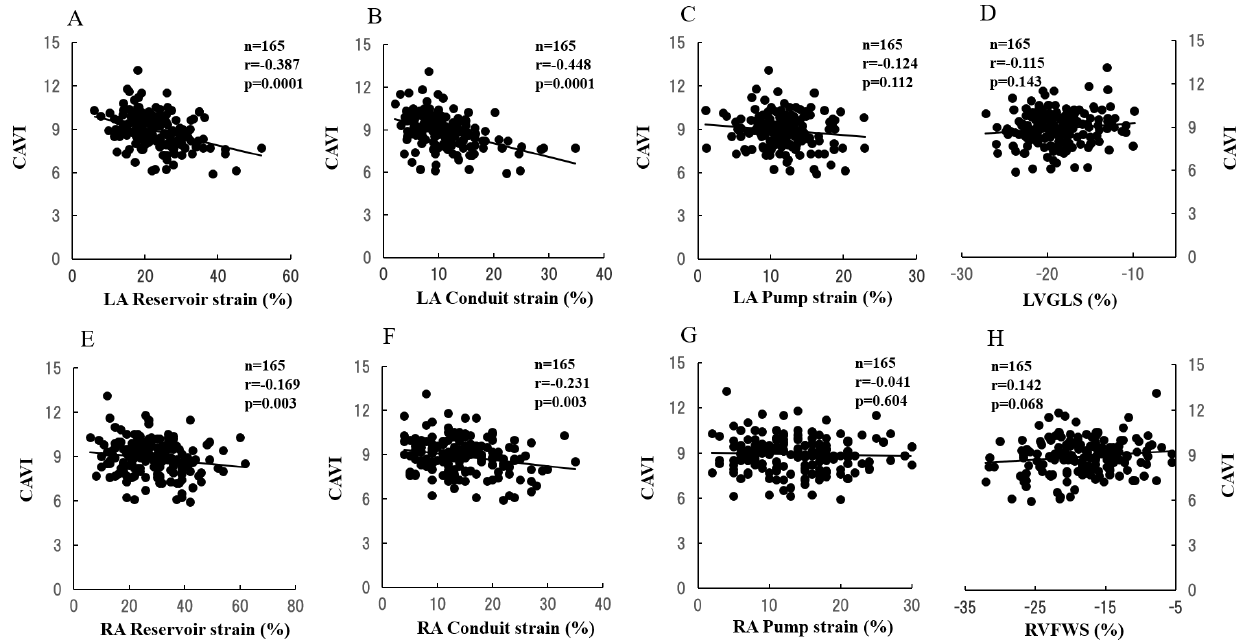
Figure 2. Correlations between the CAVI value and biatrial and biventricular strain. CAVI was corre- lated with LA reservoir strain (r = − 0.387, p = 0.0001), LA conduit strain (r = − 0.448, p = 0.0001), and RA conduit strain (r = − 0.238, p = 0.003). The solid line represents the regression line. CAVI, cardio- ankle vascular index; LA, left atrium; RA, right atrium; LVGLS, left ventricular global longitudinal strain; RVFWS, right ventricular free wall longitudinal